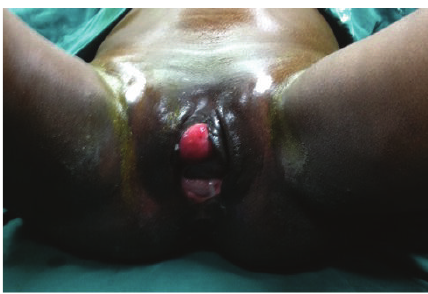
Figure 1: Image showing everted and prolapsed bladder with a bridge of tissue separating it from the vagina at presentation.